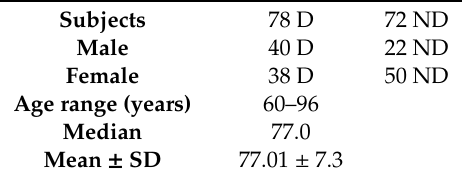
Table 1. Demographic characteristics of the subjects investigated.